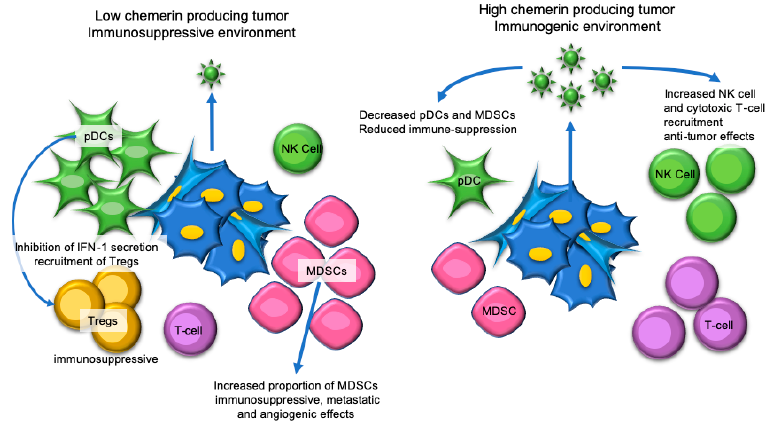
Figure 3. Chemerin has immune-mediated tumor-suppressive effects in melanoma. In low